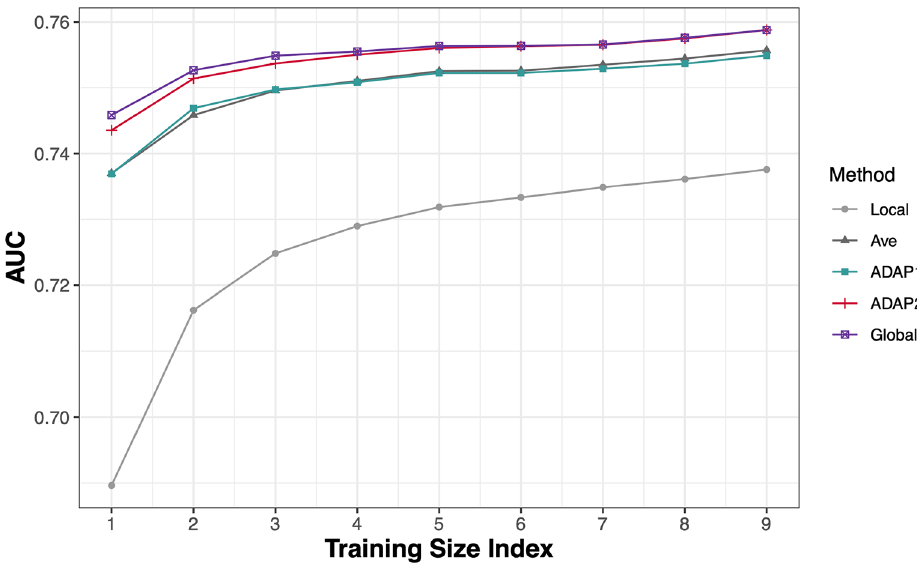
Figure 4. Prediction performance measured by averaging AUCs obtained through 200 random-splitting procedures on the OUD data. The training size index t takes values from 1 to 9, and each t means that we randomly select t × 100 cases and t × 200 controls from each site to form a training set, with the remaining data used to test the fitted model. Thus, the plot shows the pattern of variation in AUC as a function of the size of the training set. In general, as the training set size becomes larger, the AUC is increased for all methods. Among the five methods, the pooled estimator performs the best, with the performance of ADAP2 very close to that of the pooled estimator. ADAP1 and the average estimator have lower AUCs than ADAP2, and the local estimator has the worst prediction